Question: Write the caption for this figure.
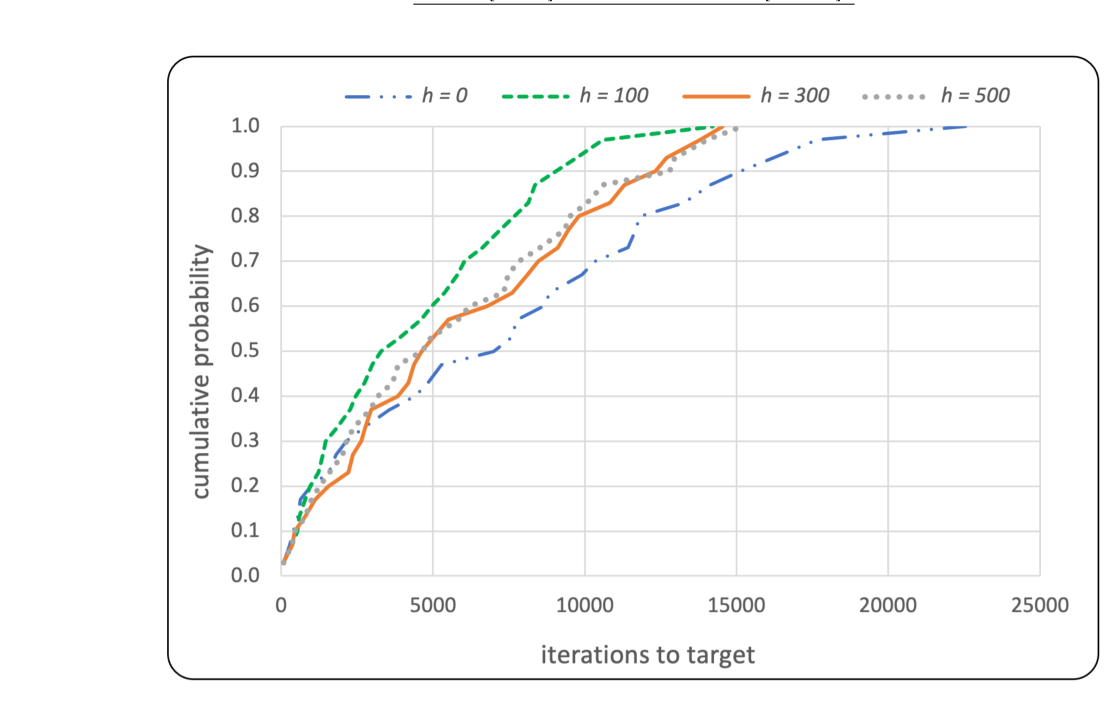
Answer: Run time distribution for analyzing of the restart parameter h: Small class